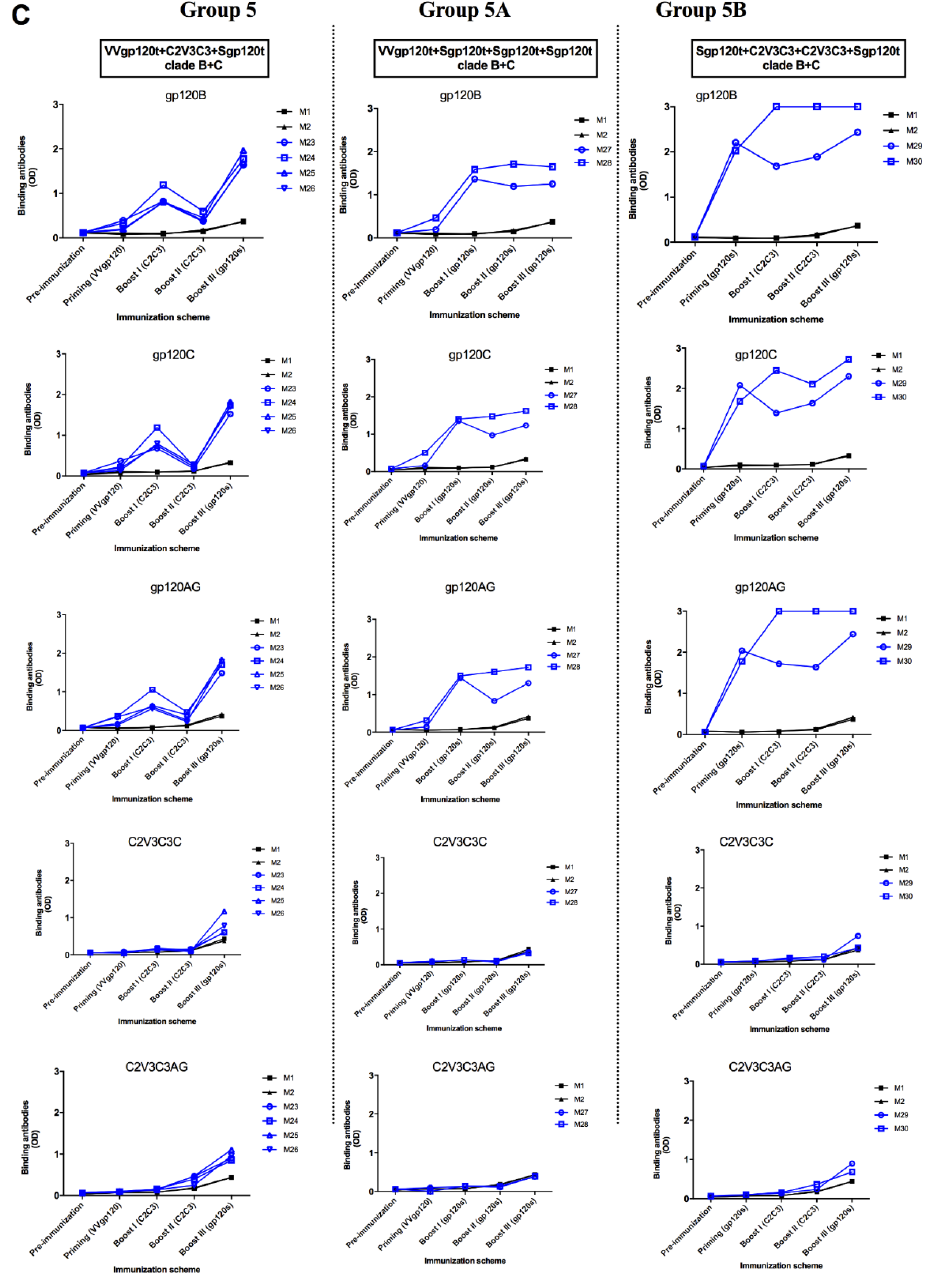
Figure 4. Evolution of the antibody binding responses against soluble gp120ts (clades B, C, CRF02_AG) and C2V3C3 polypeptides (clades C and CRF02_AG) in BALB/c mice immunized with different combinations of HIV-1 immunogens (main study): ( A ) Mice immunized with clade C immunogens; ( B ) Mice immunized with clade CRF02_AG immunogens; ( C ) Mice immunized with clades B (gp120) and C (C2V3C3) immunogens. Groups 3, 4, and 5 — mice primed with VV expressing gp120t and boosted with C2V3C3 polypeptides and Sgp120t; Groups 3A, 4A, and 5A — mice primed with VV expressing gp120t and boosted with Sgp120t; Groups 3B, 4B, and 5B — mice primed with Sgp120t and boosted with C2V3C3 polypeptides and Sgp120t. For all mice, the schedule of immunization included one priming and three boosts at days 15, 30, and 45. Fifteen days after each immunization, sera were collected and assayed for the presence of binding antibodies against HIV-1 immunogens. Blue lines represent immunized mice from the respective group; black lines represent mice from control group